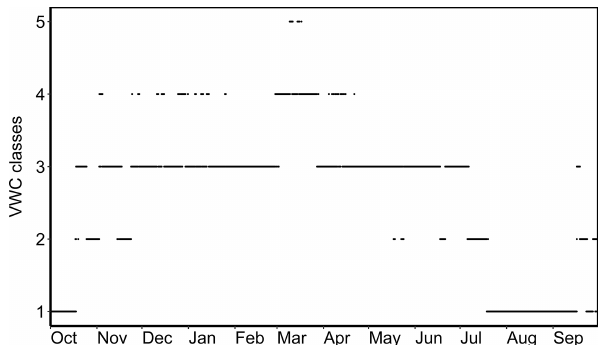
Figure 8. Volumetric water content (VWC) classes of the topsoil (from dry, Eq. 1, to wet, Eq. 5, as defined in Table 2) during the hy- drological year 2017–2018. The corresponding 30min VWC values are in Fig.